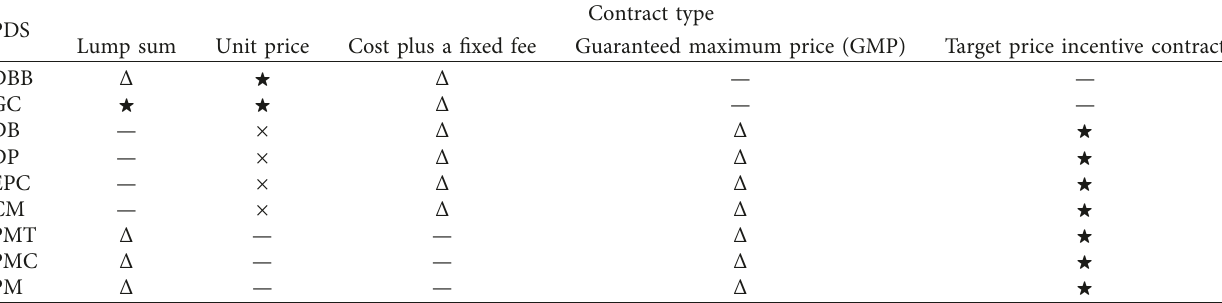
Table 2: Matching Matrix of the contract-type and project delivery system.